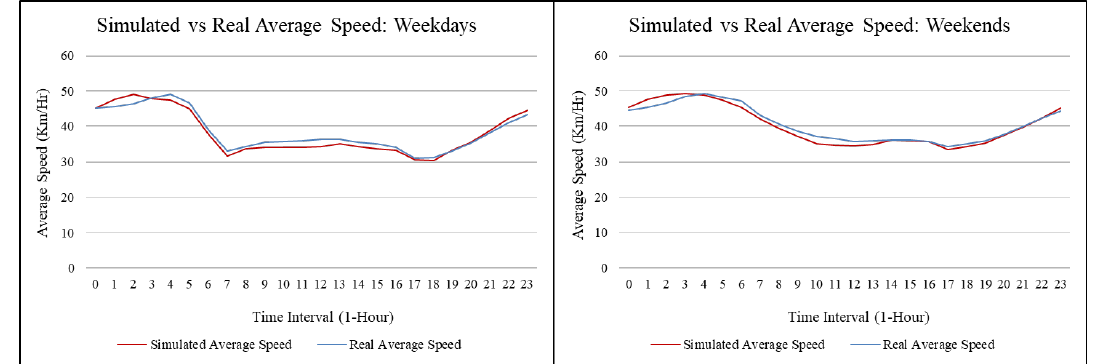
Figure 19. Average speed variation concerning hourly time interval.